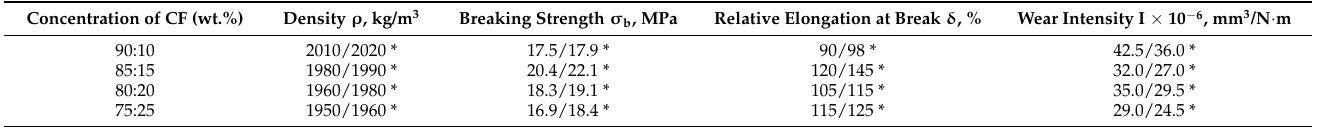
Table 3. The effect of CF concentration on the properties of PTFE composites.